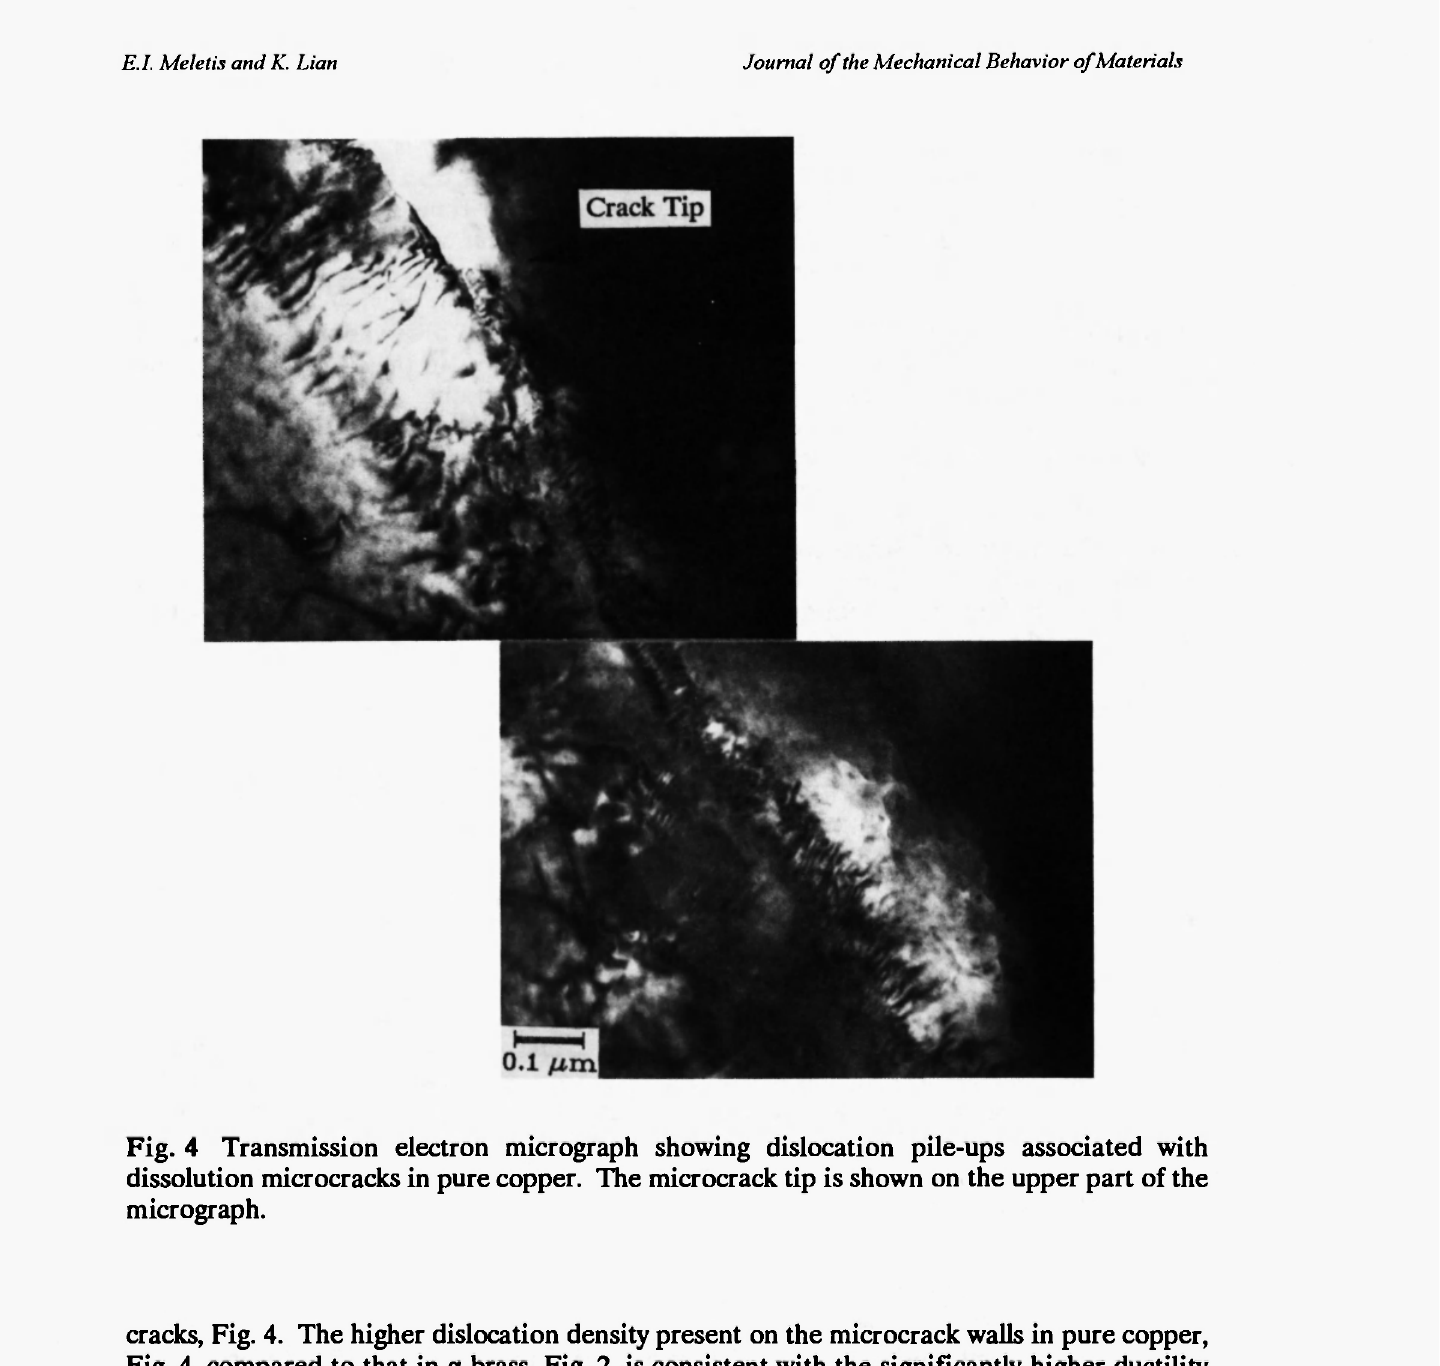
Fig. 4 Transmission electron micrograph showing dislocation pile-ups associated with dissolution microcracks in pure copper. TTie microcrack tip is shown on the upper part of the